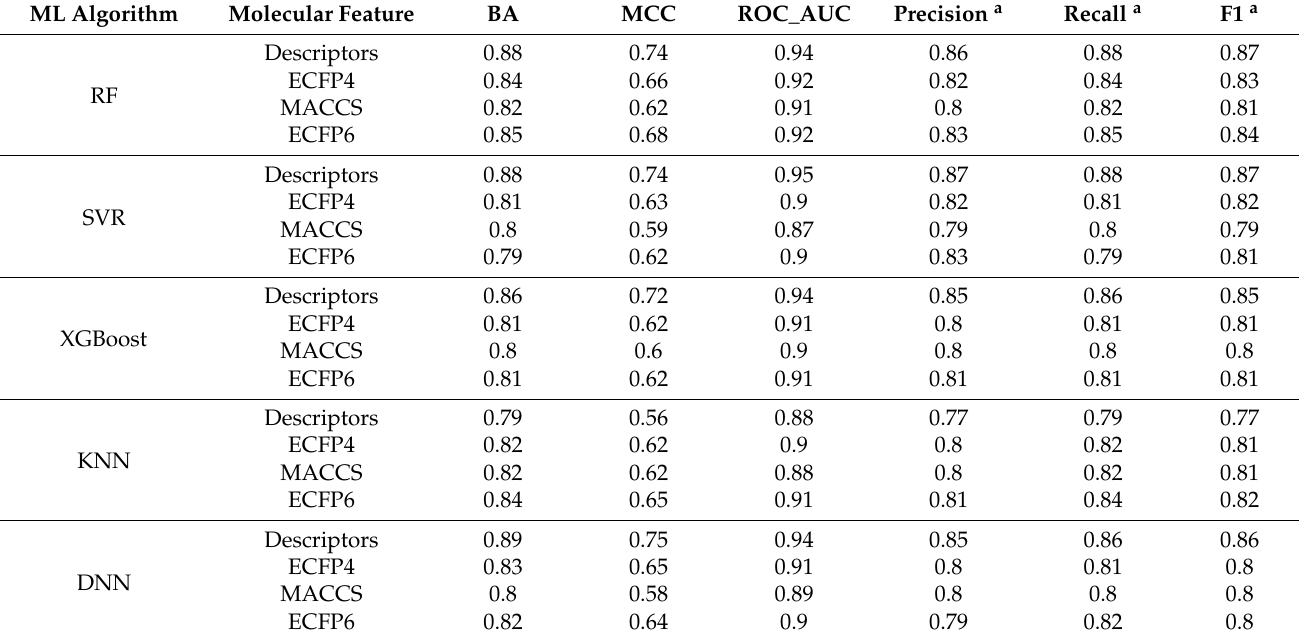
Table 3. External validation parameters of the binary classification